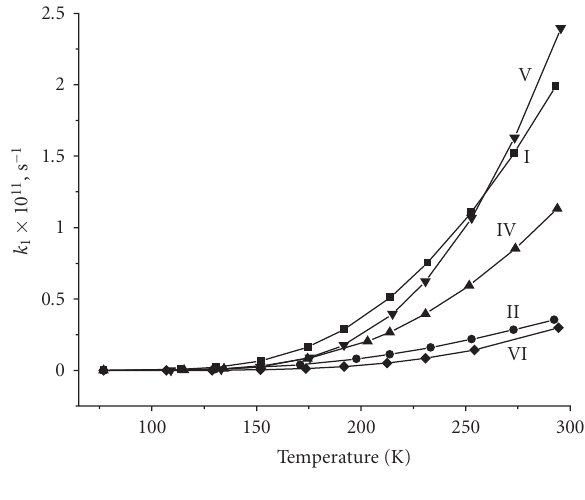
Figure 5: The rate constants of the forward photoreaction for the compounds I, IV, V in ethanol and II and VI in butyronitrile at dif- ferent temperatures in the range 293–100